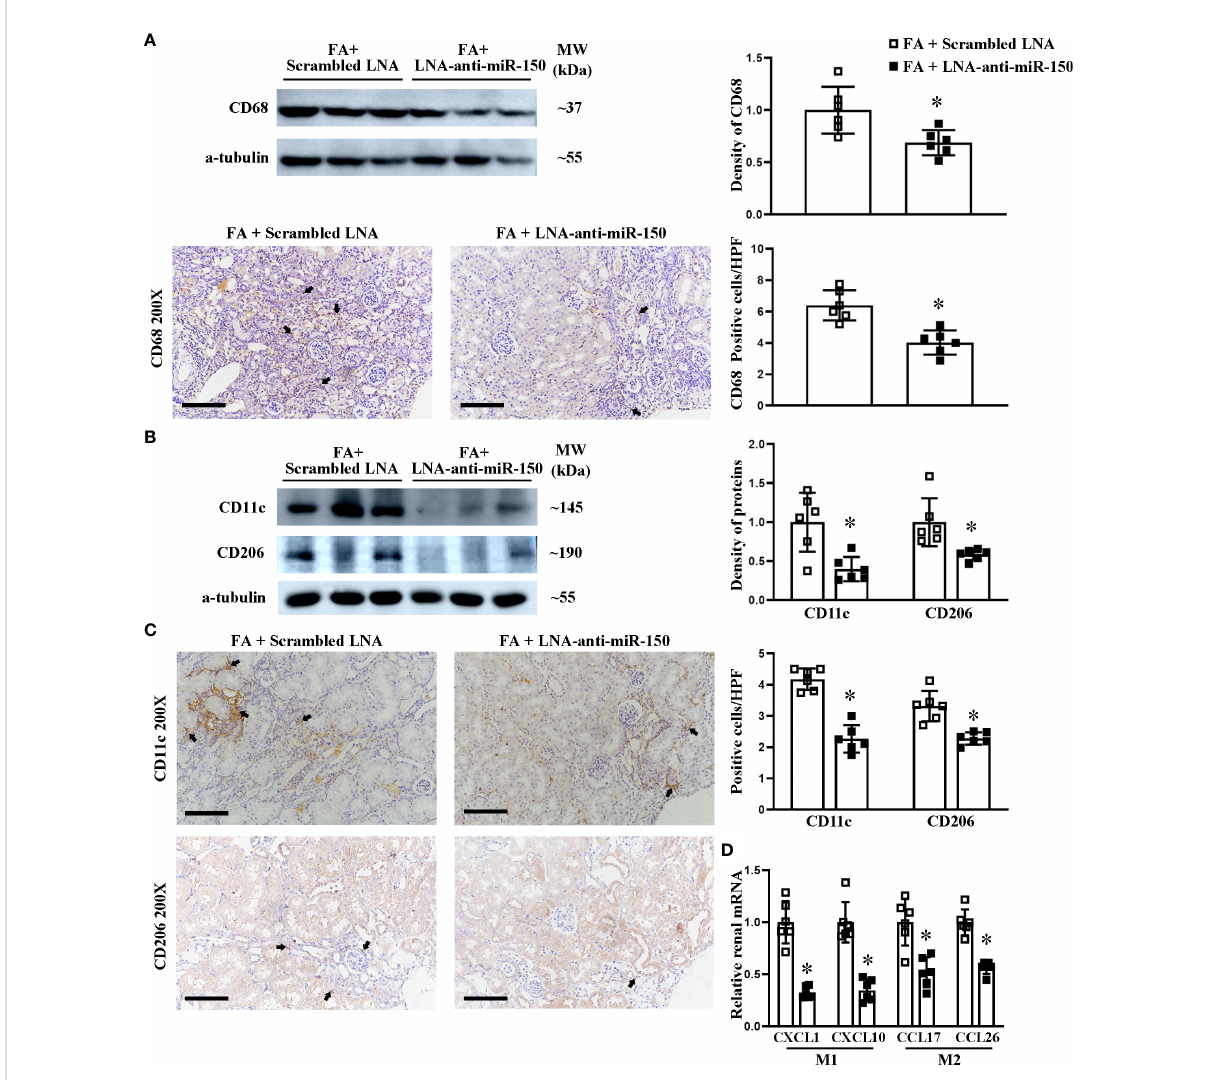
FIGURE 6 LNA-anti-miR-150 reduced the renal in fi ltration of macrophages and polarization of M1/M2 macrophages in renal interstitial fi brosis mice. Western blotting and immunohistochemical (IHC) staining of the renal expression of CD68 protein, a classic biomarker for total macrophages (A) . M1 macrophage polarization indicated by CD11c and M2 macrophage polarization indicated by CD206 expression as analyzed using Western blotting (B) and IHC staining (C) . The renal mRNA levels of M1-related cytokines CXCL1 and CXCL10 as well as M2-related cytokines CCL17 and CCL26 were quantitated by qPCR (D) . For IHC staining, magni fi cation = ×200, scale bar = 100 m m. For all semi-quanti fi cation graphs, data are presented as mean ± SD, n = 6. * p < 0.05, FA + LNA-anti-miR-150 group vs. FA + scrambled LNA